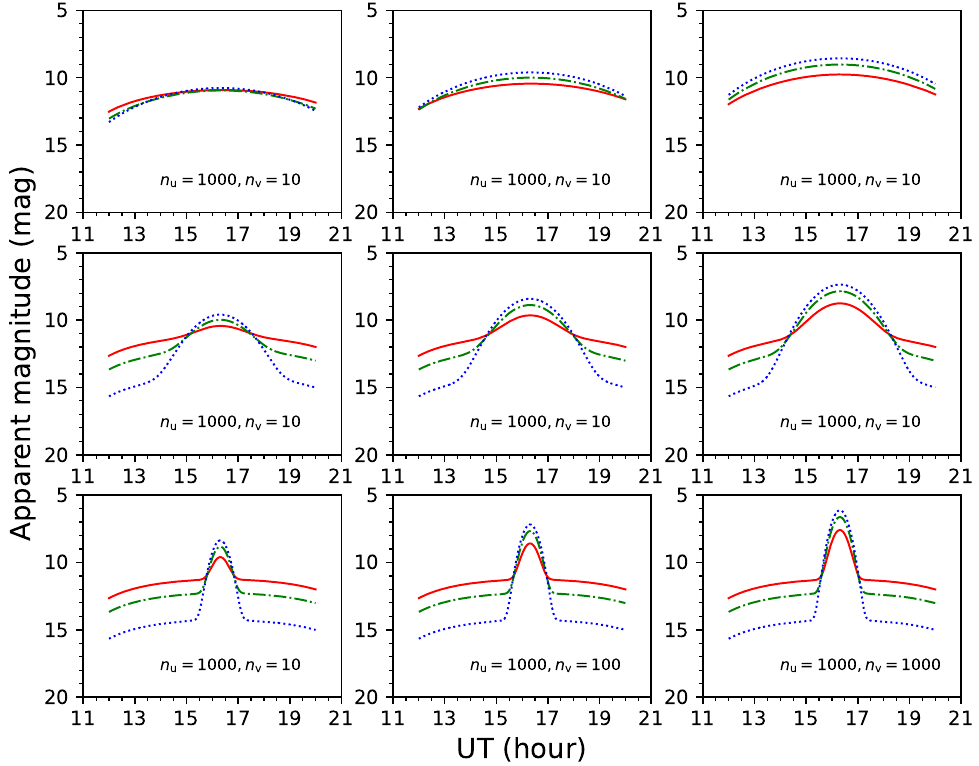
Figure 7. Synthetic light curves with different parameters of the Phong model. Red solid line: R spec = 0.2, R diff = 0.8; Green dash-dotted line: R spec = 0.5, R diff = 0.5; Blue dotted line: R spec = 0.8, R diff =